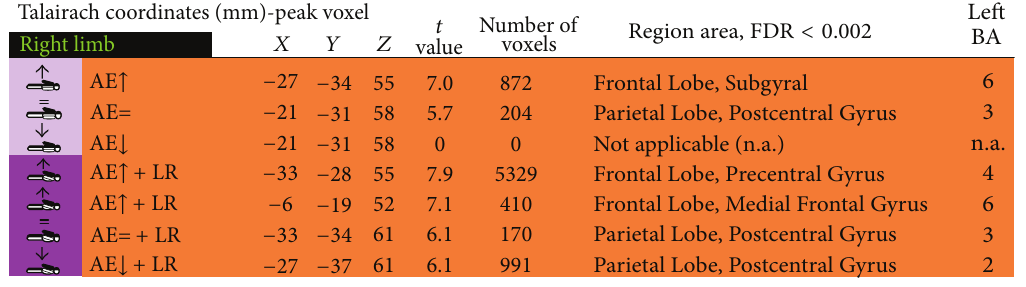
Table 1: Activated brain regions by isolated dominant arm elevation and combined dominant arm elevation with nondominant upper limb restriction.